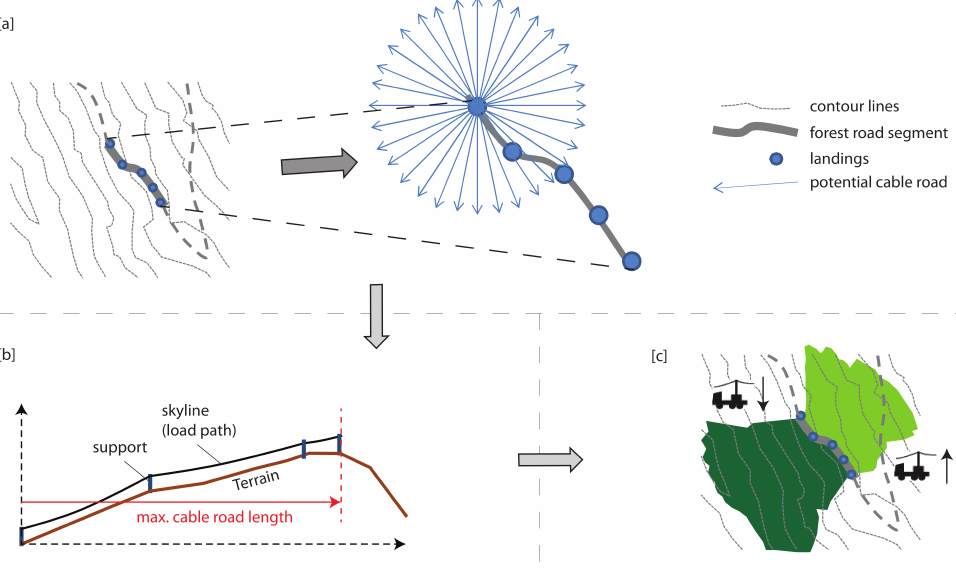
Figure 5. Workflow for analysis of yarder accessibility. ( a ) Potential landings are placed on road segments; at each landing, radial lines indicate potential cable roads; ( b ) Each potential cable road is checked for maximum feasible distance, based on terrain properties; ( c ) Accessible timber parcels along each cable road are collected and stored for each